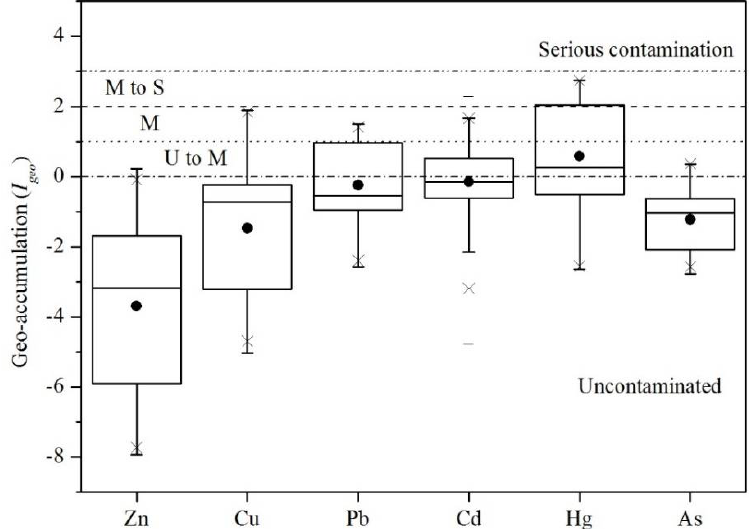
Figure 5. The Box-plots of geo-accumulation index ( I geo ), ‘U to M’—uncontaminated to moderate, ‘M’—moderate contamination, ‘M to S’—moderate to serious contamination.